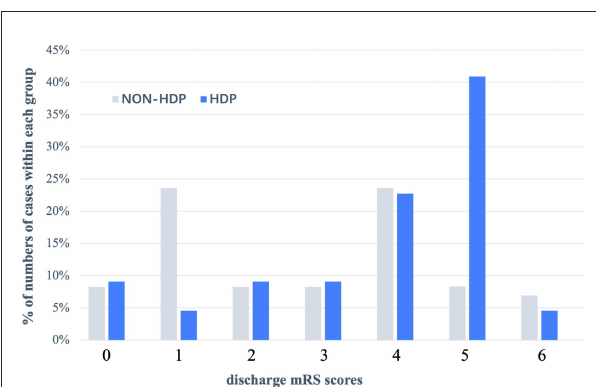
FIGURE1 Distribution (expressed as a percentage) of mRS scores at discharge in patients with HDP and without HDP in pregnancy—associated hemorrhagic stroke. In patients without HDP, their discharge mRS score were evenly distributed, but in patients with HDP, discharge with mRS = 4 (22.7%) or mRS = 5 (40.9%) accounted for the main proportion. HDP, hypertensive disorder of pregnancy; mRS scores, modified Rankin